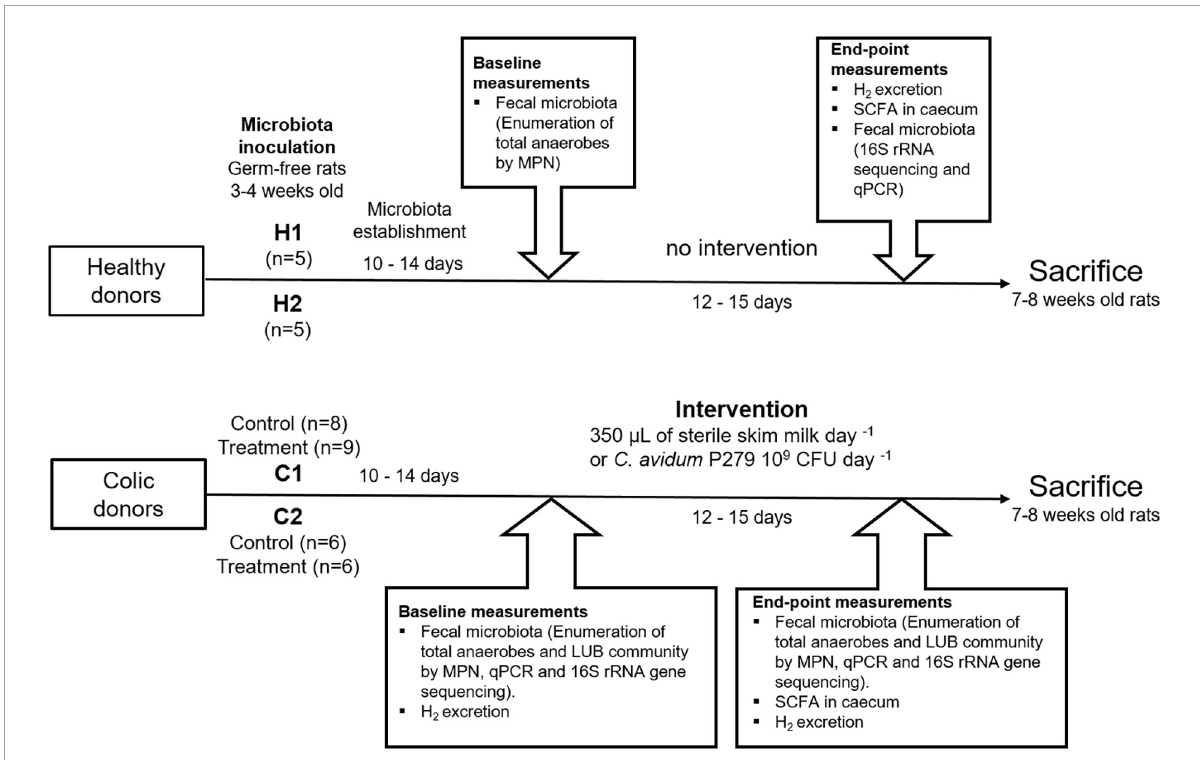
FIGURE1 Diagram of the experimental design. Fecal samples from two healthy (H1 and H2) and two colic infants (C1 and C2) were used for inoculation of germ-free Fischer 344 rats ( n = 39). The microbiota was allowed to establish for 10–14 days before baseline (T0) measurements. Rats inoculated with donors C1 and C2 were divided into treatment group (gavaged daily with 10 9 colony forming units of Cutibacterium avidum P279 in 350 µ L of sterile skim milk) and control group (received 350 µ L of sterile skim milk). End-point measurements (T1) were obtained on days 26–28. Rats were sacrificed at 7–8 weeks of age. Rats were fed a gamma-irradiated infant formula to mimic an infant diet and supplemented with 1–3 pellets per day of standard diet for growing animals. All rats were given free access to sterile